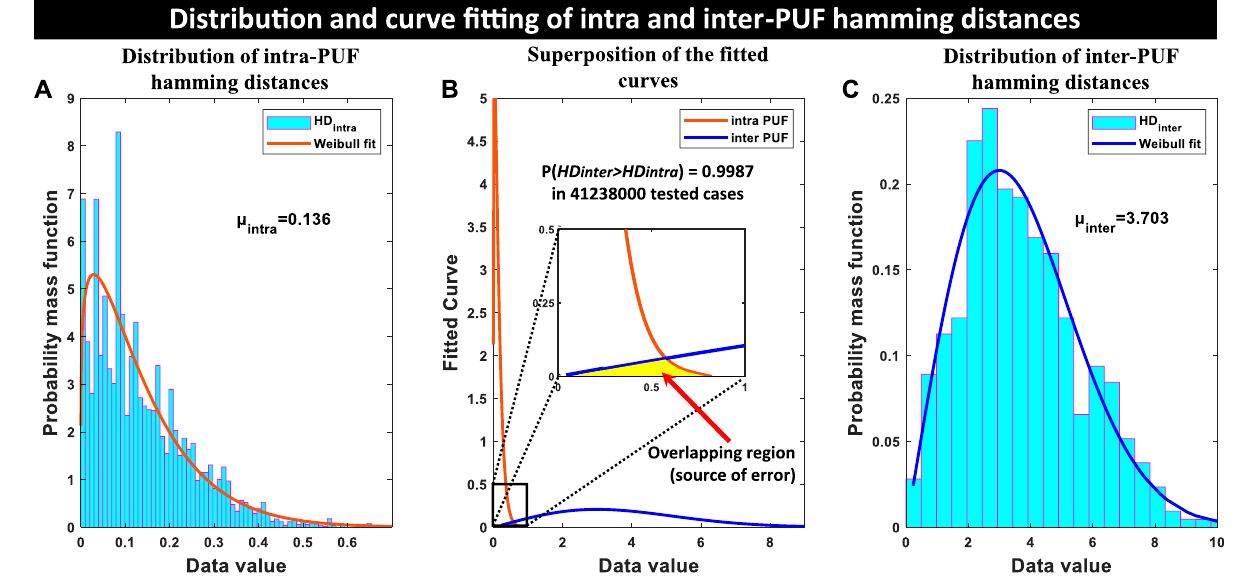
FIGURE 8 | Data distribution of (A) intra-PUF hamming distances and (C) inter-PUF hamming distances. Due to skewness, Weibull distribution fi tting is a more accurate representation in these cases. (B) The two Weibull curves are superimposed on top of each other. It is seen that there is a very slight overlap (yellow region) between the curves which is shown in a zoomed inset. Although trivial, this overlapping is the source of the detection error.